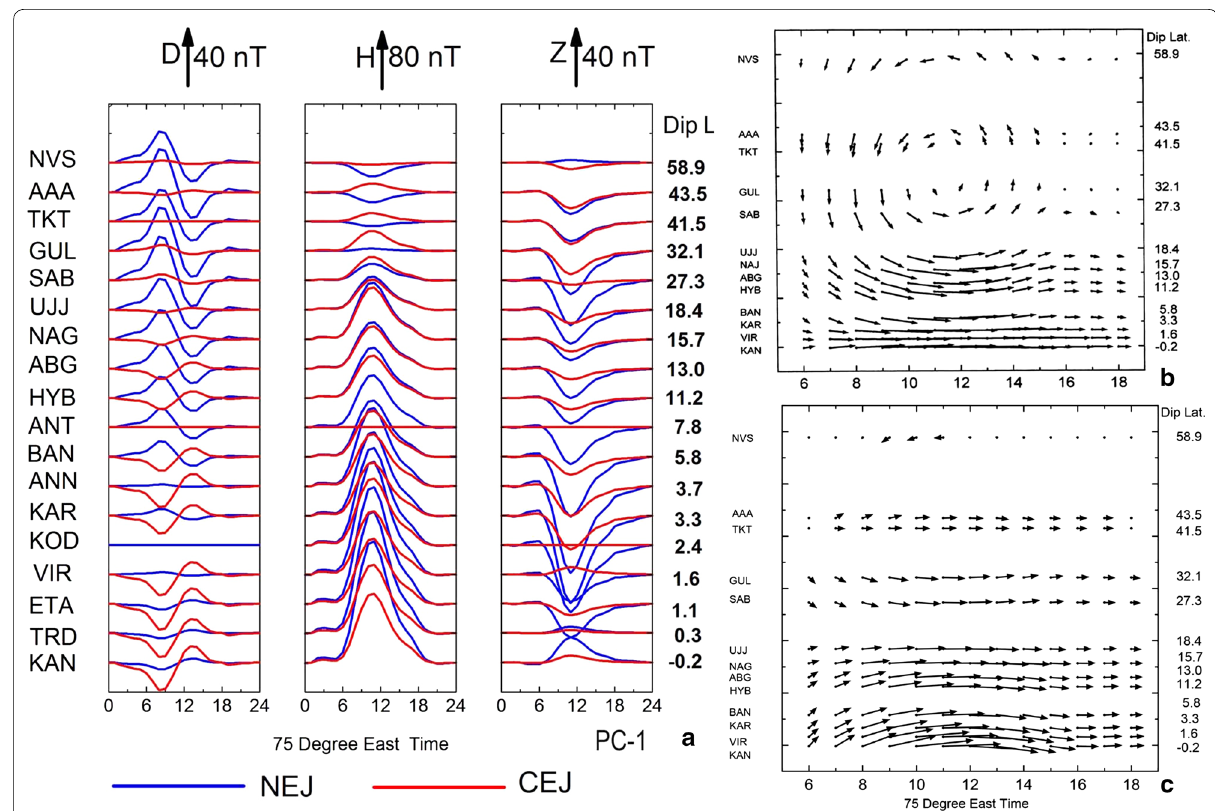
Fig. 2 a Comparison of H-, D-, and Z-components on an NEJ day ( blue curves ; February 6, 1992) and a CEJ day ( red curves ; January 23, 1992) for PC-1 along the Indo-Russian chain of stations, showing the reduced amplitude of H-variations on the CEJ day. b Plot of equivalent current vectors on the local time latitude sector for PC-1 during the NEJ day, with the Sq focus between GUL and TKT (~35° dip latitude). c Plot of equivalent current vec- tors on the local time latitude sector for PC-1 during the CEJ day, showing the absence of a clear